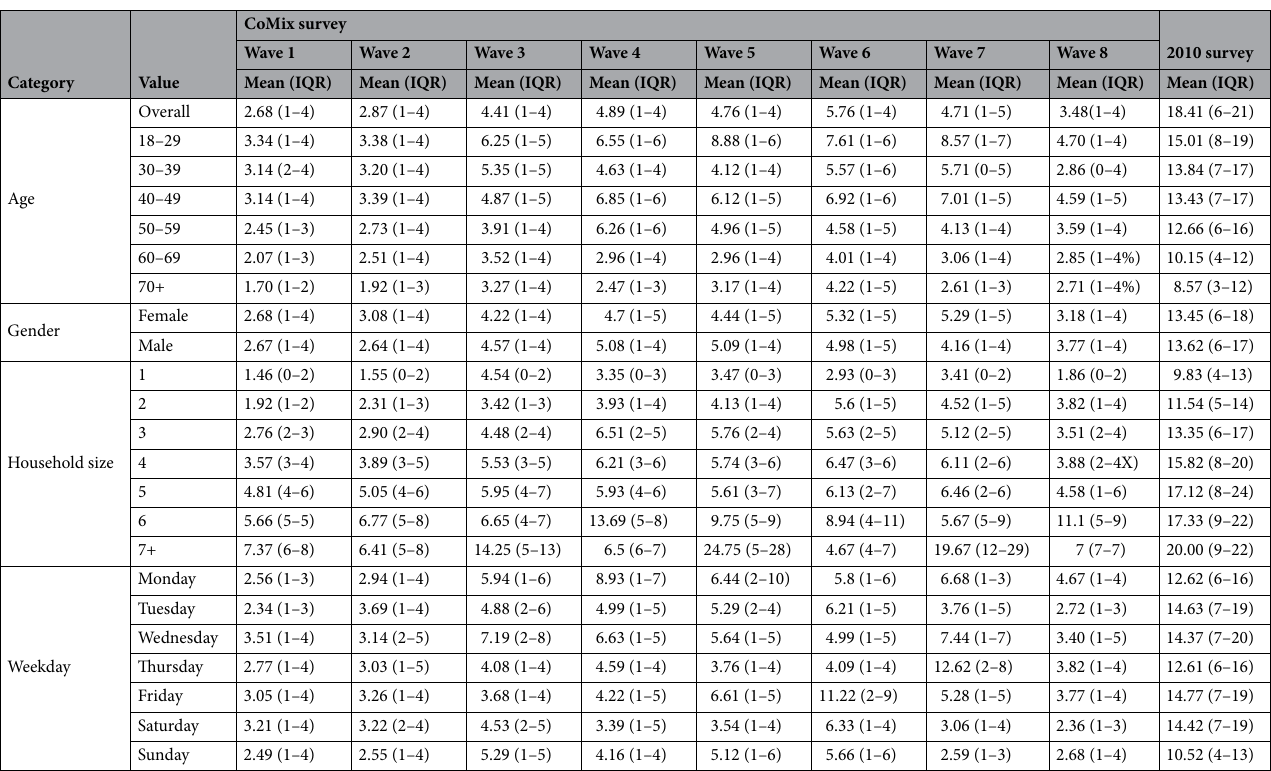
Table 2. Average number of